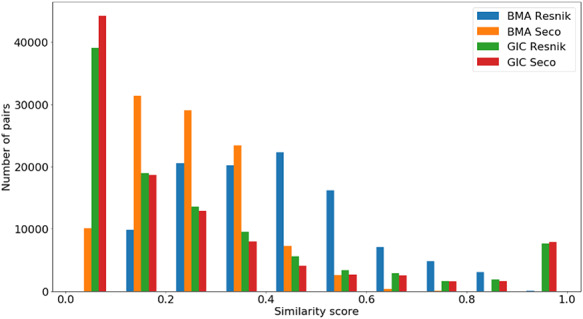
Distribution of all semantic similarity metrics (\documentclass[12pt]{minimal}
\usepackage{amsmath}
\usepackage{wasysym}
\usepackage{amsfonts}
\usepackage{amssymb}
\usepackage{amsbsy}
\usepackage{upgreek}
\usepackage{mathrsfs}
\setlength{\oddsidemargin}{-69pt}
\begin{document}
}{}${\rm{BM}}{{\rm{A}}_{{\rm{Resnik}}}},{\rm{BM}}{{\rm{A}}_{{\rm{Seco}}}}, simGI{C_{{\rm{Resnik}}}}$\end{document}and \documentclass[12pt]{minimal}
\usepackage{amsmath}
\usepackage{wasysym}
\usepackage{amsfonts}
\usepackage{amssymb}
\usepackage{amsbsy}
\usepackage{upgreek}
\usepackage{mathrsfs}
\setlength{\oddsidemargin}{-69pt}
\begin{document}
}{}$simGI{C_{Seco}}$\end{document}) values across all species’ protein pairs in the protein family data sets.